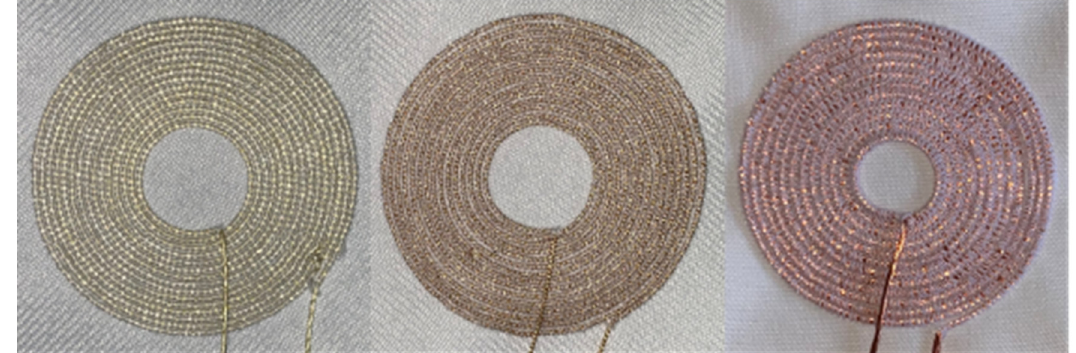
Figure 3. Embroidered coils with a diameter of 50 mm (from left to right) 50E12 ELITEX, 50U12 wrapping yarn, 50L12 copper wire.